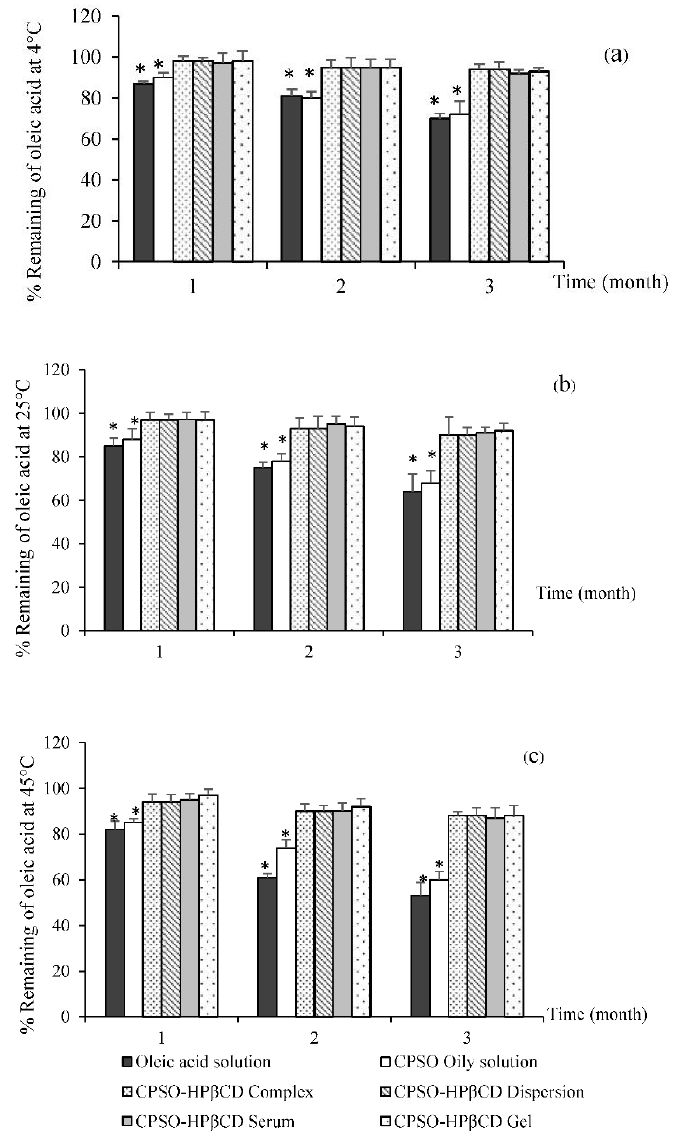
Figure 2. Chemical stability presented as perfect remaining of oleic acid in various formulations at ( a ) 4 °C, ( b ) 25 °C, and ( c ) 45 °C for three months. ( a ) 4 ◦ C, ( b ) 25 ◦ C, and ( c ) 45 ◦ C for three